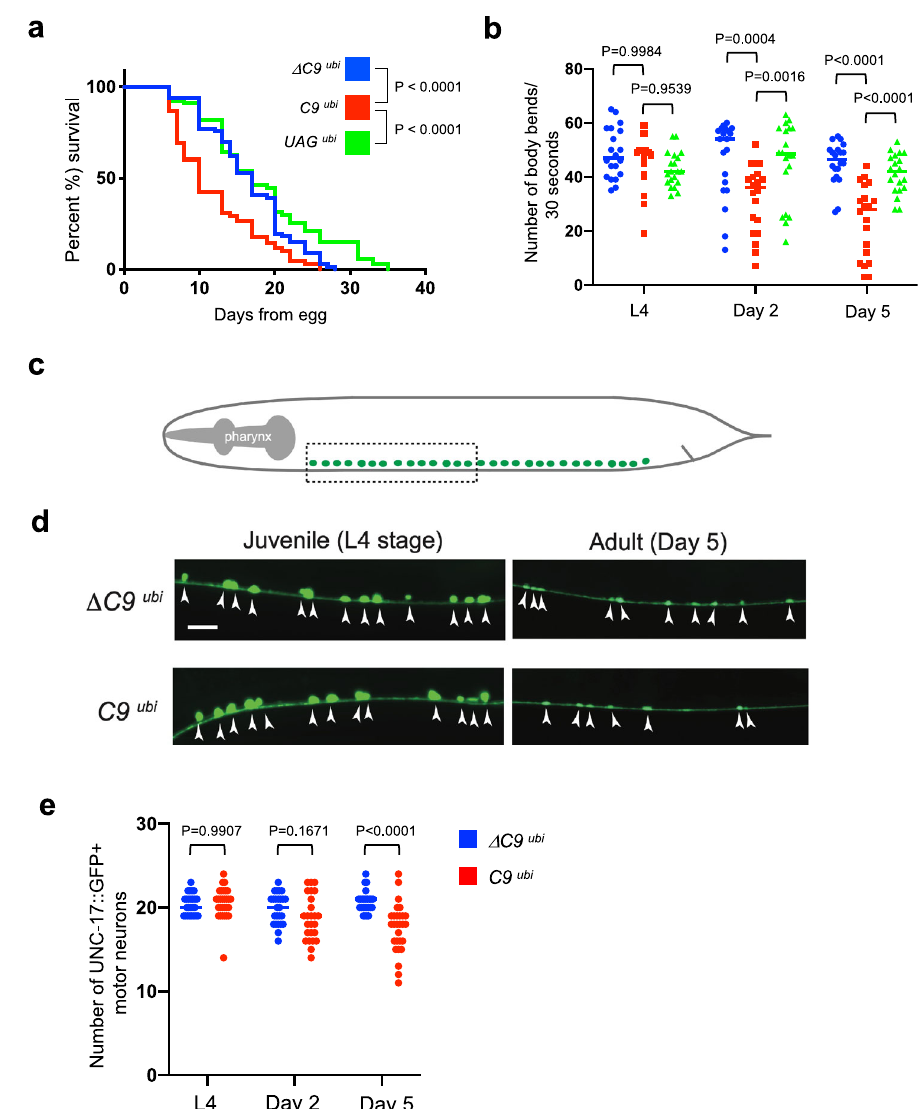
Fig. 2 Evidence for motor neuron degeneration and synaptic defects in C9 ubi animals. a Lifespan of Δ C9 ubi (kasEx154 , kasEx259 , kasEx260 ), C9 ubi ( kasEx153 , kasEx261 , kasEx262 ), and UAG ubi (kasEx155 , kasEx263 , kasEx264 ) animals. Three different transgenic lines per genotype were used and the results are combined per genotype. Δ C9 ubi , n = 66; C9 ubi , n = 68; UAG ubi , n = 67). See Supplementary Fig. 7. Mantel – Cox log-rank test was performed. b Swimming rates of Δ C9 ubi (kasIs9-blue) , C9 ubi (kasIs7-red) , and UAG ubi (kasIs10-green) worms at three different stages. n = 20. Two-way ANOVA with Š ídák ’ s multiple comparison test was performed. c Schematic showing cholinergic motor neurons (green) in the C . elegans ventral nerve cord. Dashed box indicates the region used for imaging and quanti fi cation. d , e Motor neuron cell bodies are visualized with the vsIs48 [ unc-17/VAChT::gfp] marker in Δ C9 ubi (KasIs9) and C9 ubi (KasIs7) animals at the indicated stages. Arrowheads indicate motor neuron cell bodies. Scale bar = 10 μ m. e Quanti fi cation of the number of motor neurons at the anterior half of the nerve cord. L4 Δ C9 ubi : n = 25, day 2 Δ C9 ubi : n = 25, day 5 Δ C9 ubi : n = 25, L4 C9 ubi : n = 29, day 2 C9 ubi : n = 25, day 5 Δ C9 ubi : n = 28. Two-way ANOVA with Š ídák ’ s multiple comparison test was